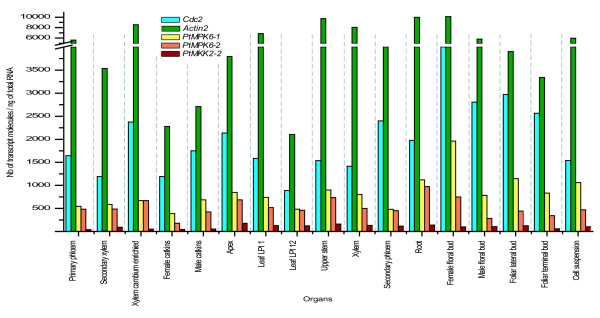
Steady-state transcript accumulation for cdc2, Act2 and three kinase genes throughout the surveyed organs (indicated at the bottom of the figure). After determination of RTqPCR primers efficiency and generation of standard curves, RTqPCR analysis was performed for cdc2, Act2, and for two poplar MPKs as well as for one poplar MKK. Twelve nanograms of cDNA were used in each RTqPCR reaction. Results are expressed in number of specific transcripts per ng of total RNA. Values represent the mean of six independent reactions (two repeats for each of three independent samples). Cts were determined using single fluorescent readings that were taken after each cycle.